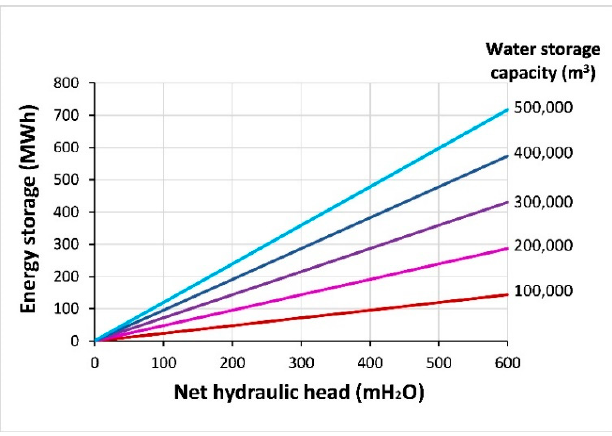
Figure 1. Storable amount of energy of an UPSH plant, considering a turbine efficiency of 90%.